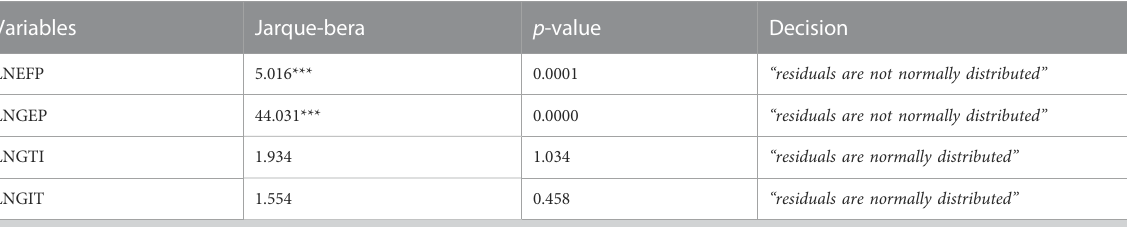
TABLE 2 Test of normality.